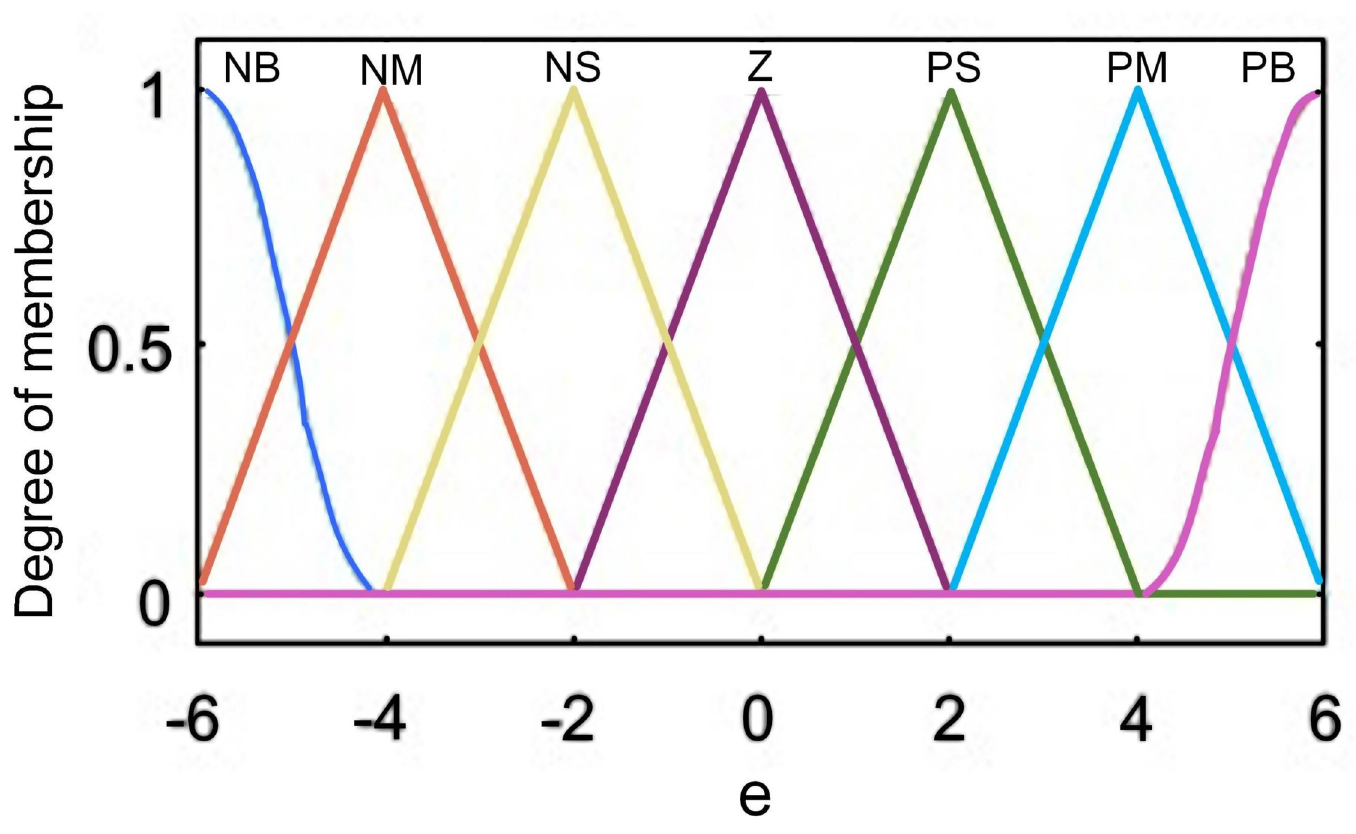
Fig 14. Affiliation function of unwinding tension deviation bias e .